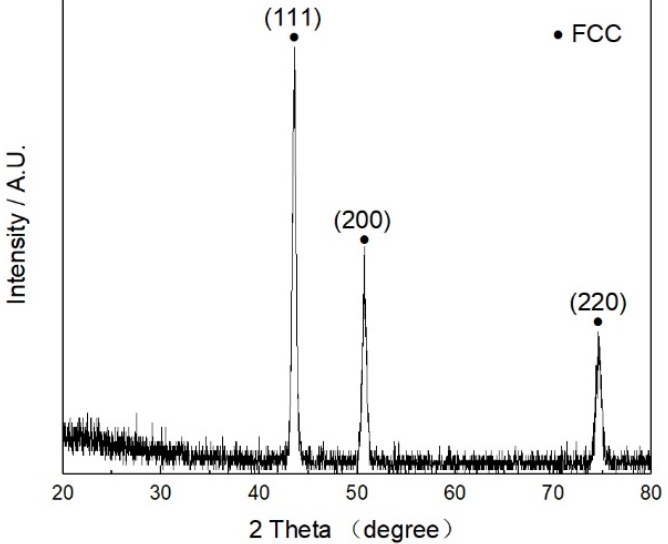
Figure 2. XRD pattern of the CoCrFeNiMn powder.